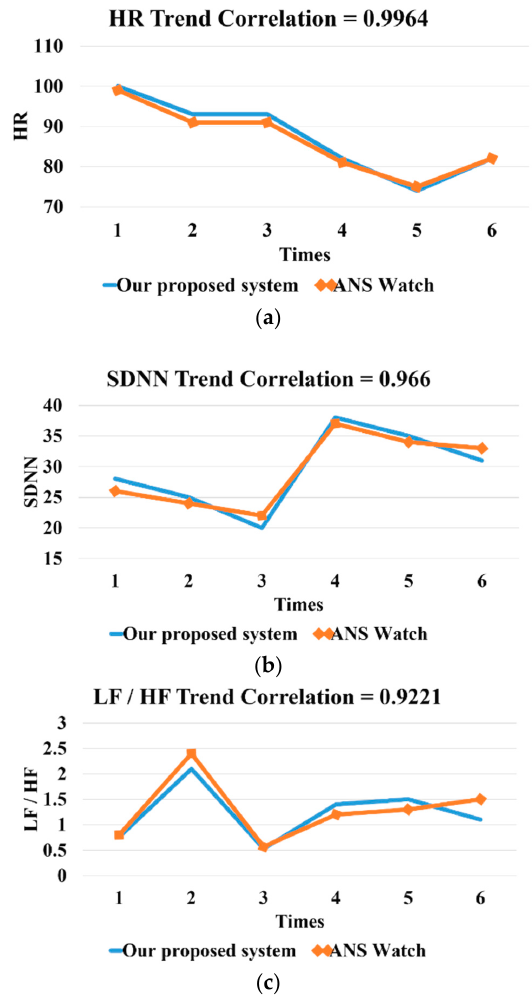
Figure 8. ( a )The HR (heart rate) correlation. ( b ) The HRV (SDNN) correlation. ( c ) The LF/HF ratio correlation.